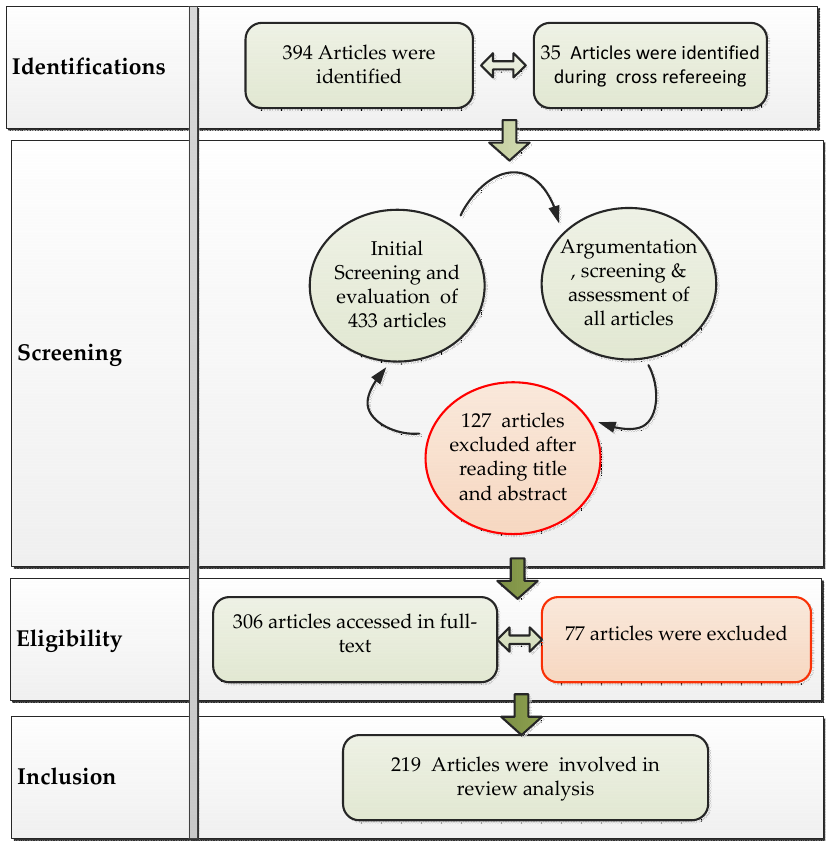
Figure 2. Schematic diagram of the literature selection, evaluation and quality control process of the database using the Prisma guidelines.